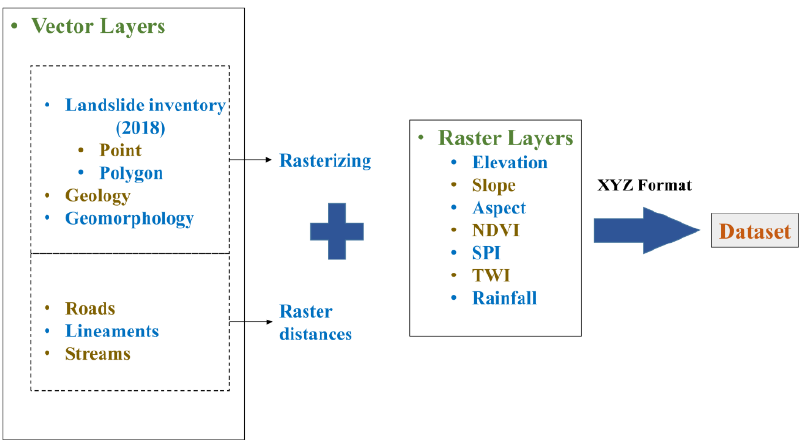
Figure 4. Schematic representation of dataset preparation from different spatial layers collected.